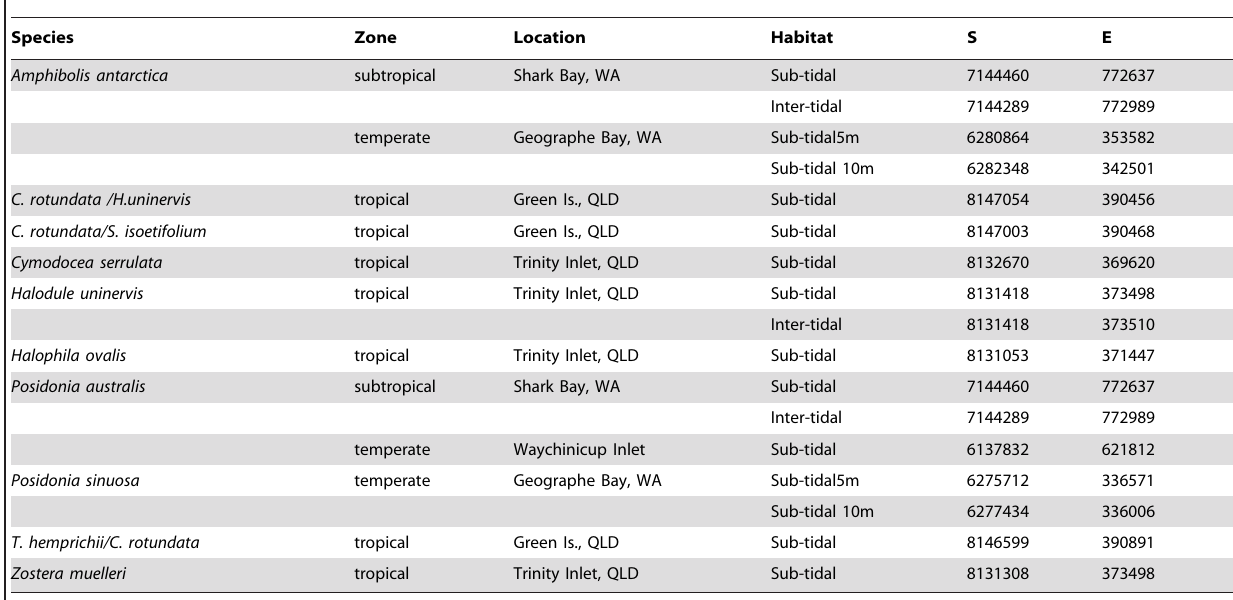
Table 1. Location of seagrass meadow sampling